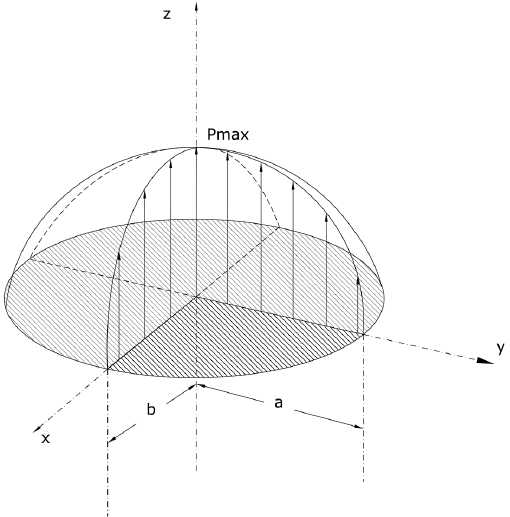
Figure 2. A Hertzian distribution of contact pressure .